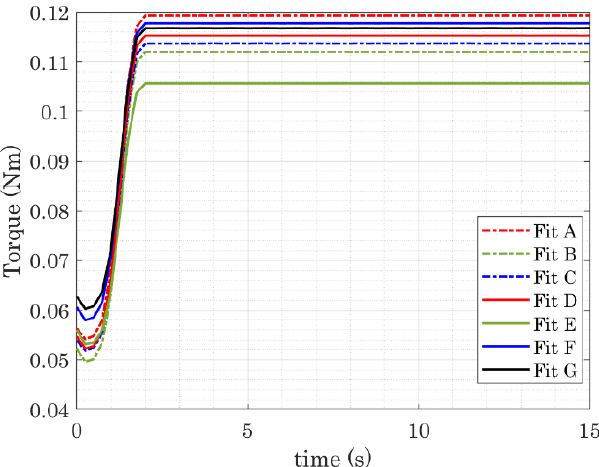
Figure 14. Blade cuts showing the flow across the blade for ( a , d , g ) the cross-section near the hub, ( b , e , h ) the mid-span cross-section, and ( c , f , i ) the cross-section near the tip for Fit A ( a – c ), Fit B ( d – f ), and Fit C ( g – i ) configurations.